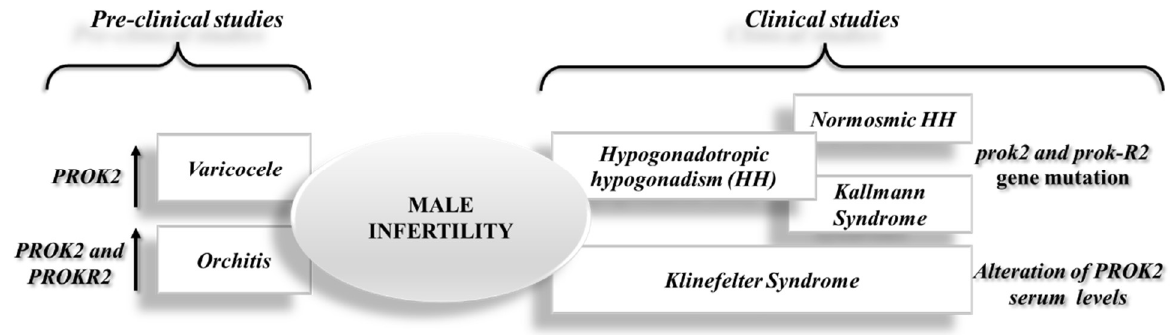
Figure 2. Schematic representation of recent advance on the role of the PROK2 system in male infertility from pre-clinical and clinical studies. infertility from pre-clinical and clinical